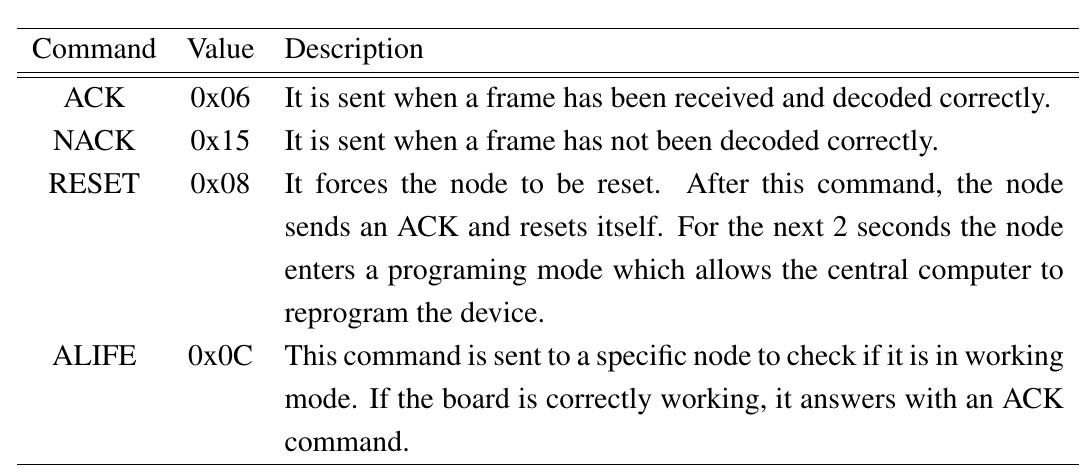
Table 2. Communication protocol: commands defined.